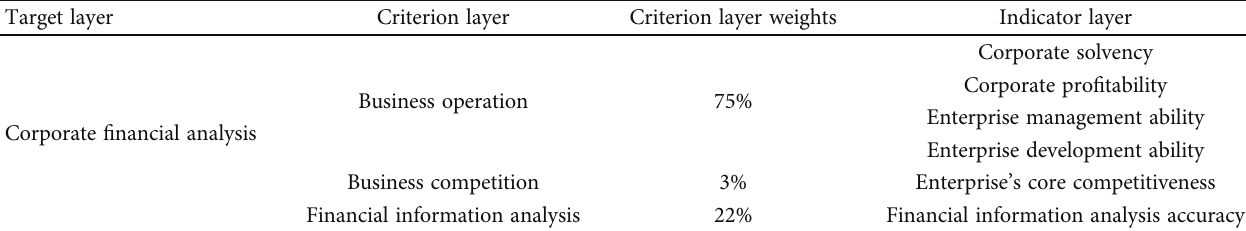
Table 2: Hierarchical structure table of enterprise fi nancial analysis.